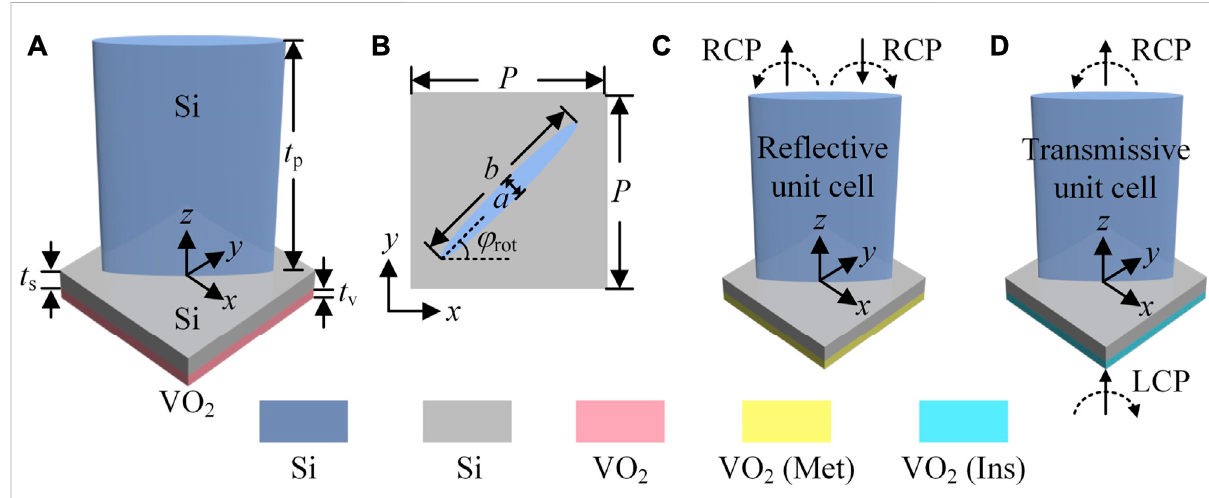
FIGURE 2 Schematic diagram of the unit cell composed of the top Si elliptical pillar and Si-VO 2 substrate (A) Stereoscopic view (B) Vertical view (C) Re fl ective unit cell (D) Transmissive unit cell. p = 550 μ m, t p = 900 μ m, t s = 5 μ m, t v = 0.2 μ m, a = 54 μ m, and b = 520 μ m.